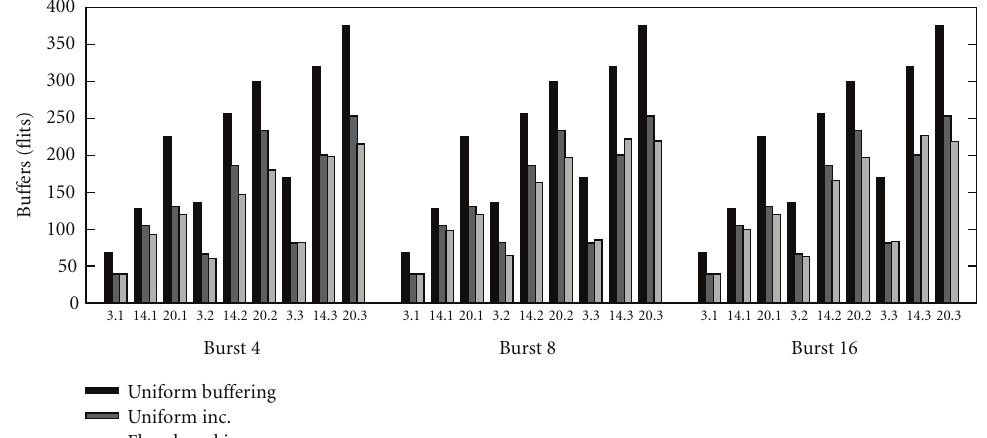
Figure 9: Comparison of di ff erent bu ff er-sizing strategies.